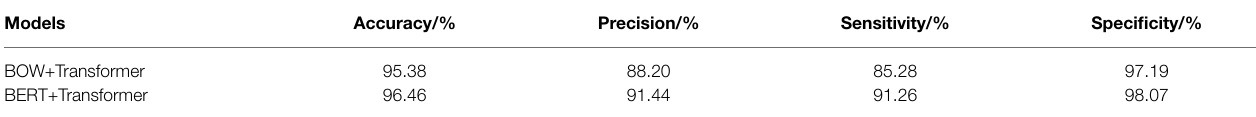
TABLE 6 | Comparison of the results in the text control